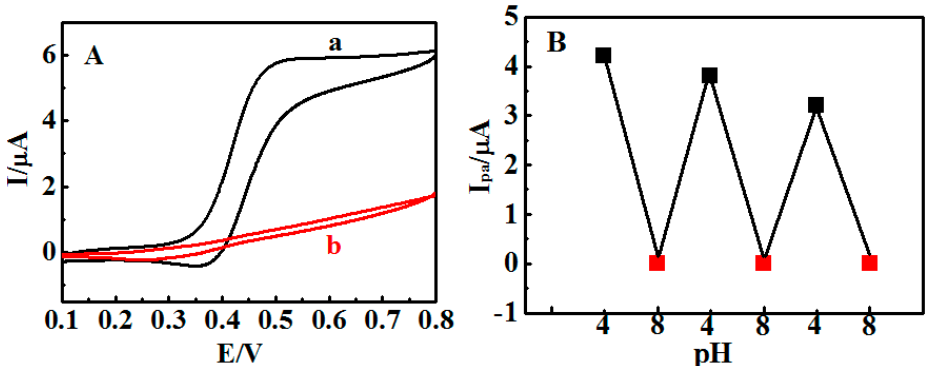
Figure 8. ( A ) CVs of {Con A/GOD} 5 films at 0.005 V·s − 1 in solutions containing 0.5 mM Fc(COOH) 2 , 7.0 mM glucose at pH ( a ) 4.0 and ( b ) 8.0; ( B ) Dependence of CV catalytic I pa at 0.005 V·s − 1 on solution pH switched between pH 4.0 and 8.0, which tuned by alternate addition of 10 mM ethyl butyrate (black square) and 6 mM urea (red square) into unbuffered solutions containing 5 units·mL − 1 esterase, 15 units·mL − 1 urease, 0.5 mM Fc(COOH) 2 , and 7.0 mM glucose for the same {Con A/GOD} 5 films.